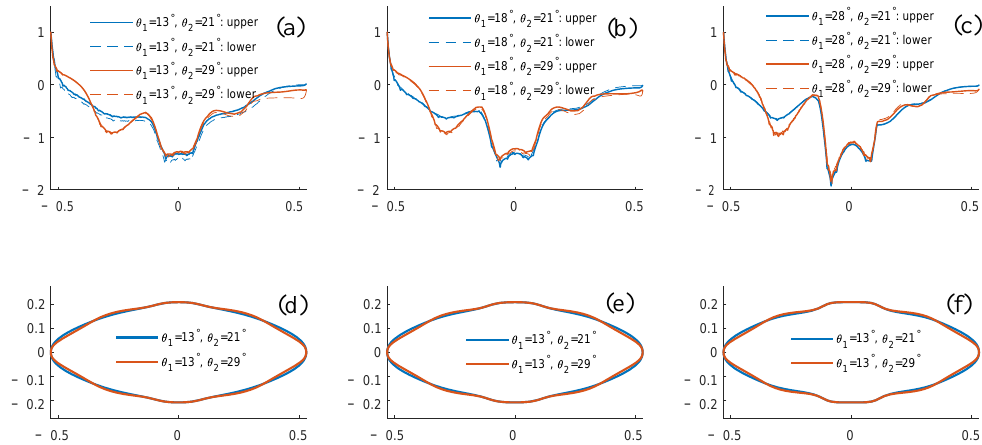
Figure 10. The comparison of pressure distribution around AUH’s hull and corresponding AUH contours with different parameters: pressure distribution around AUH’s upper and lower for ( a ) θ C = 13 ◦ , θ D = 21 ◦ and θ C = 13 ◦ , θ D = 29 ◦ ; ( b ) θ C = 18 ◦ , θ D = 21 ◦ and θ C = 18 ◦ , θ D = 29 ◦ ; ( c ) θ C = 28 ◦ , θ D = 21 ◦ and θ C = 28 ◦ , θ D = 29 ◦ ; ( d – f ): corresponding AUH’s hull respectively.